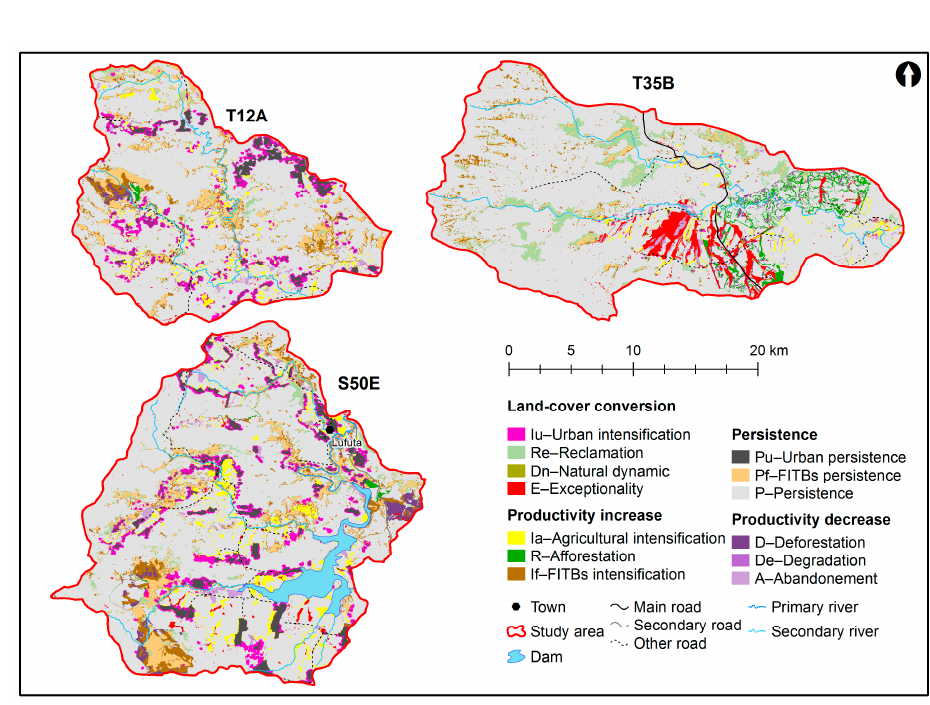
Figure 4. Indicator-based approach for land cover conversion.